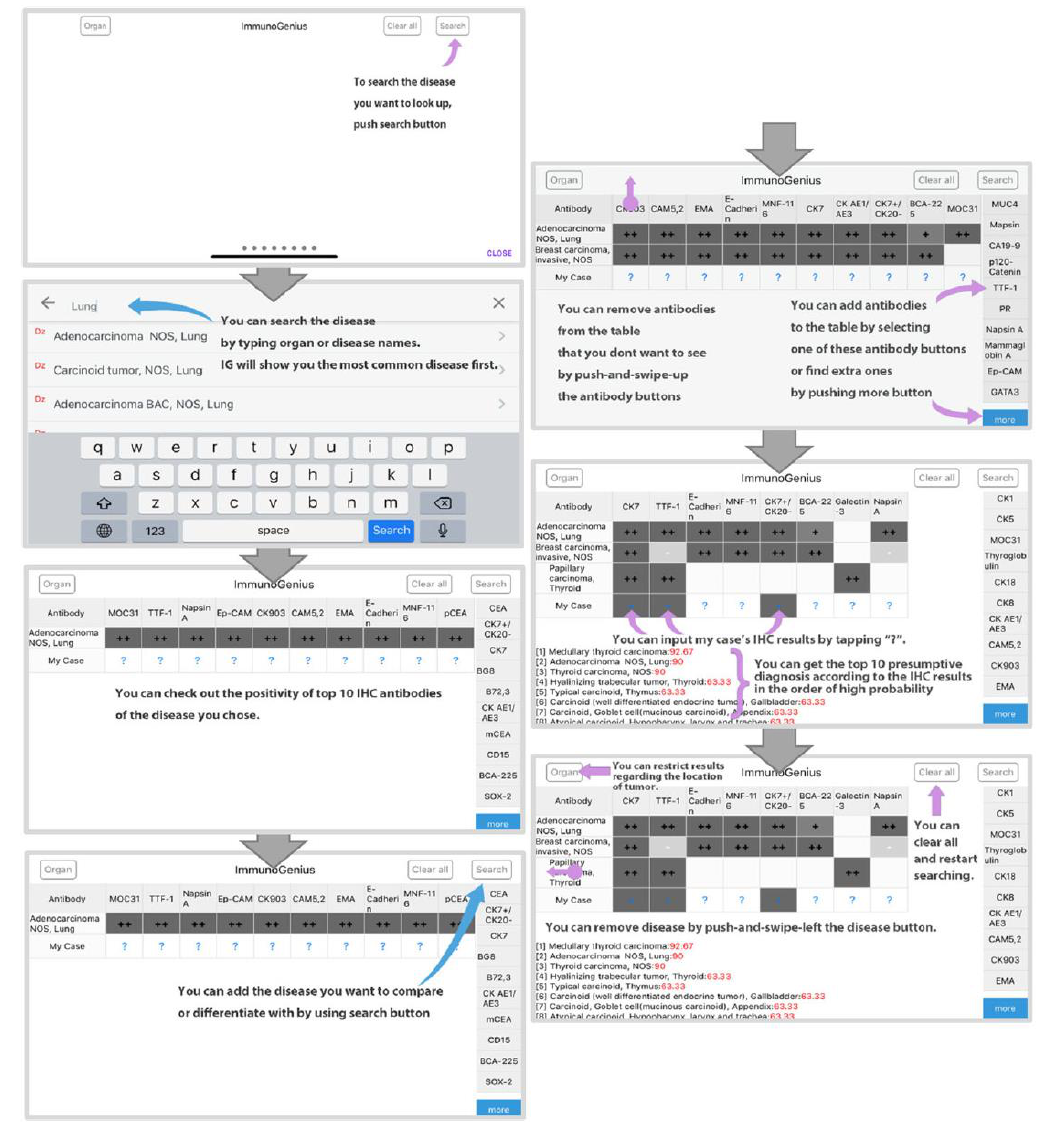
Figure 2. Exemplary flowchart for ImmunoGenius.